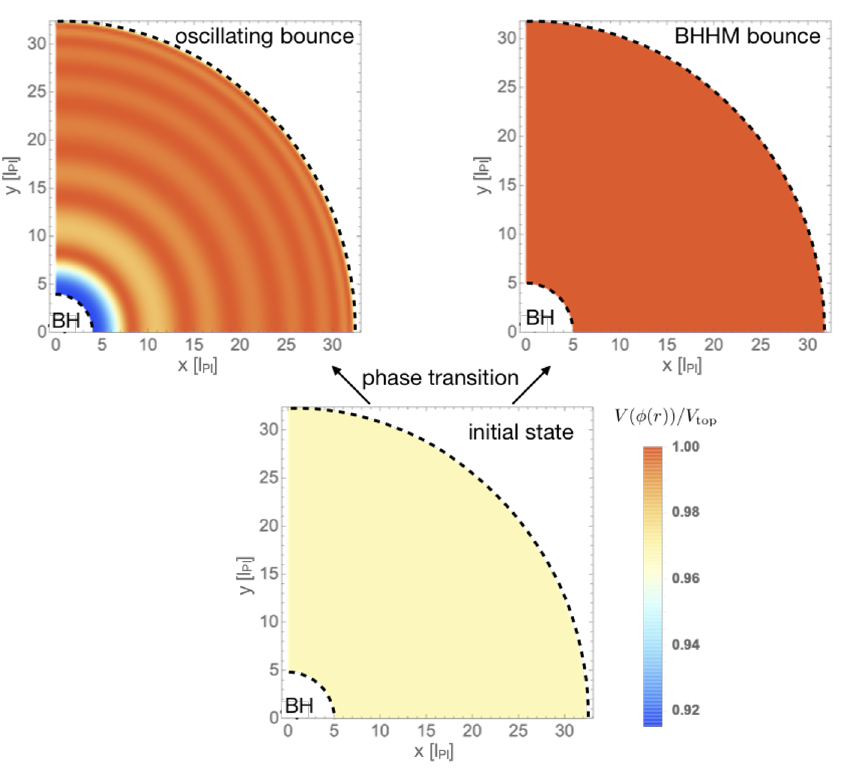
Figure 9 . The vacuum energy density pro(cid:12)les (color shows the value of V ( (cid:30) ( r )) =V top ) of the oscillating bounce ( k = 7), BHHM bounce, and the initial state. Dashed lines denote the BH